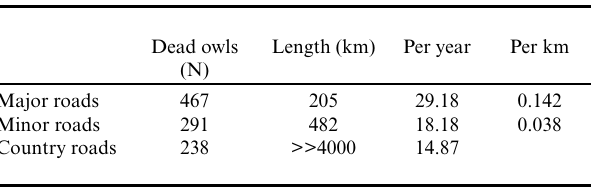
Table 1 . Number of road deaths of ringed Barn Owls ( Tyto alba ) in Friesland on major roads, minor roads, and country roads in the period 1994–2009 (N = 996). Road length is the total for the entire Province of Friesland. Most Barn Owl victims occur at major roads (corrected for road length, major and minor road comparison Chi-squared yields p < 0.00001). Because total road length of country roads is unknown, an average for owl mortality per km country road cannot be provided.